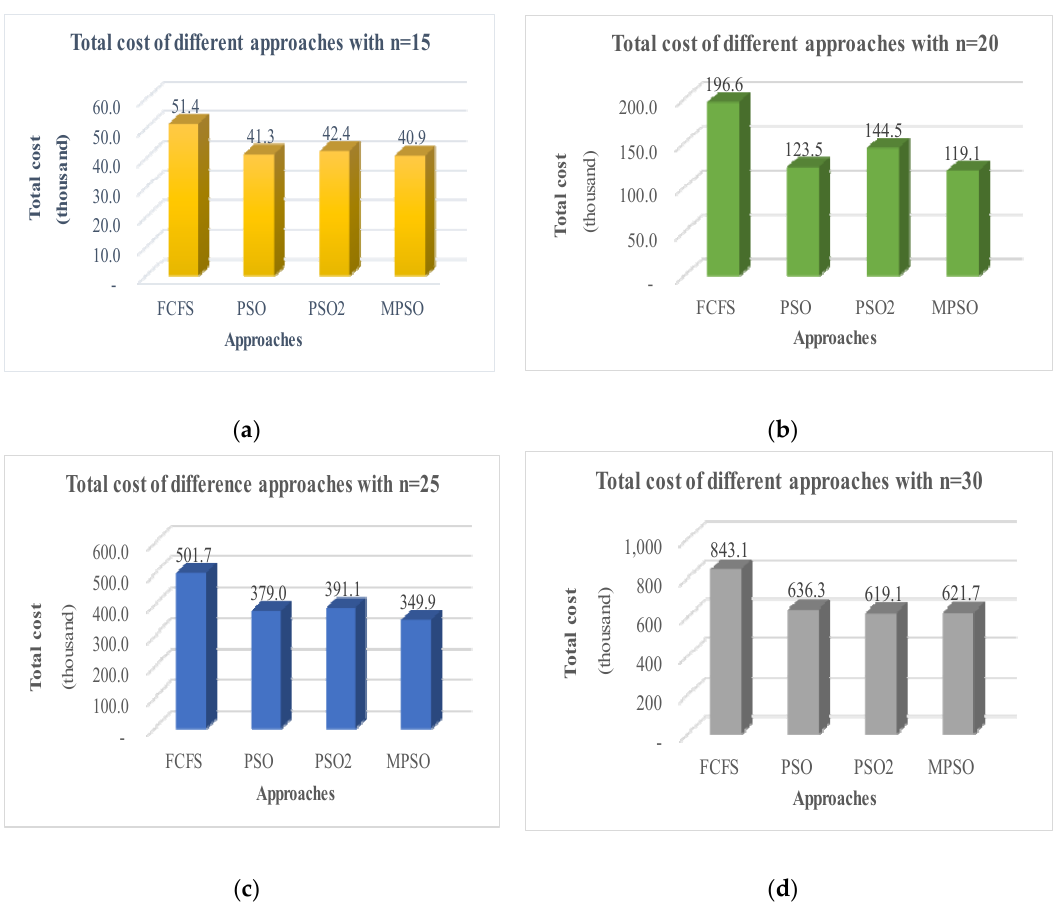
Figure 15. ( a ) Comparisons of total costs (n = 15); ( b ) comparisons of total costs (n = 20); ( c ) comparisons of total costs (n = 25); ( d ) comparisons of total costs (n = 30).